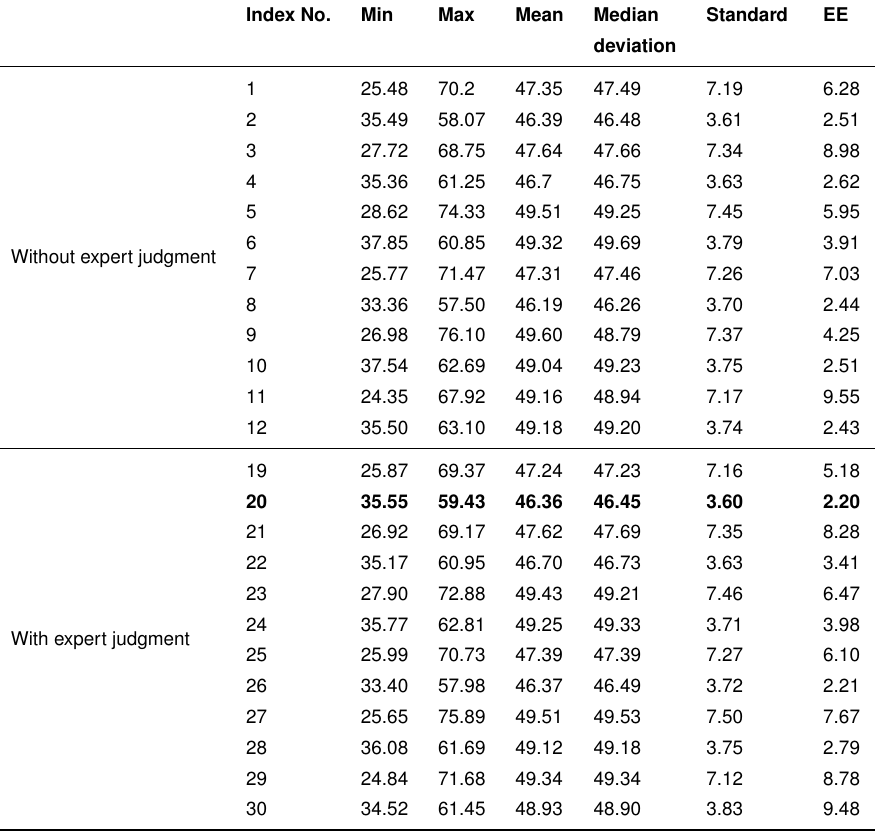
Table 3. Descriptive statistics and estimation errors for the HSI constructed using 1000 simulated count data. Index